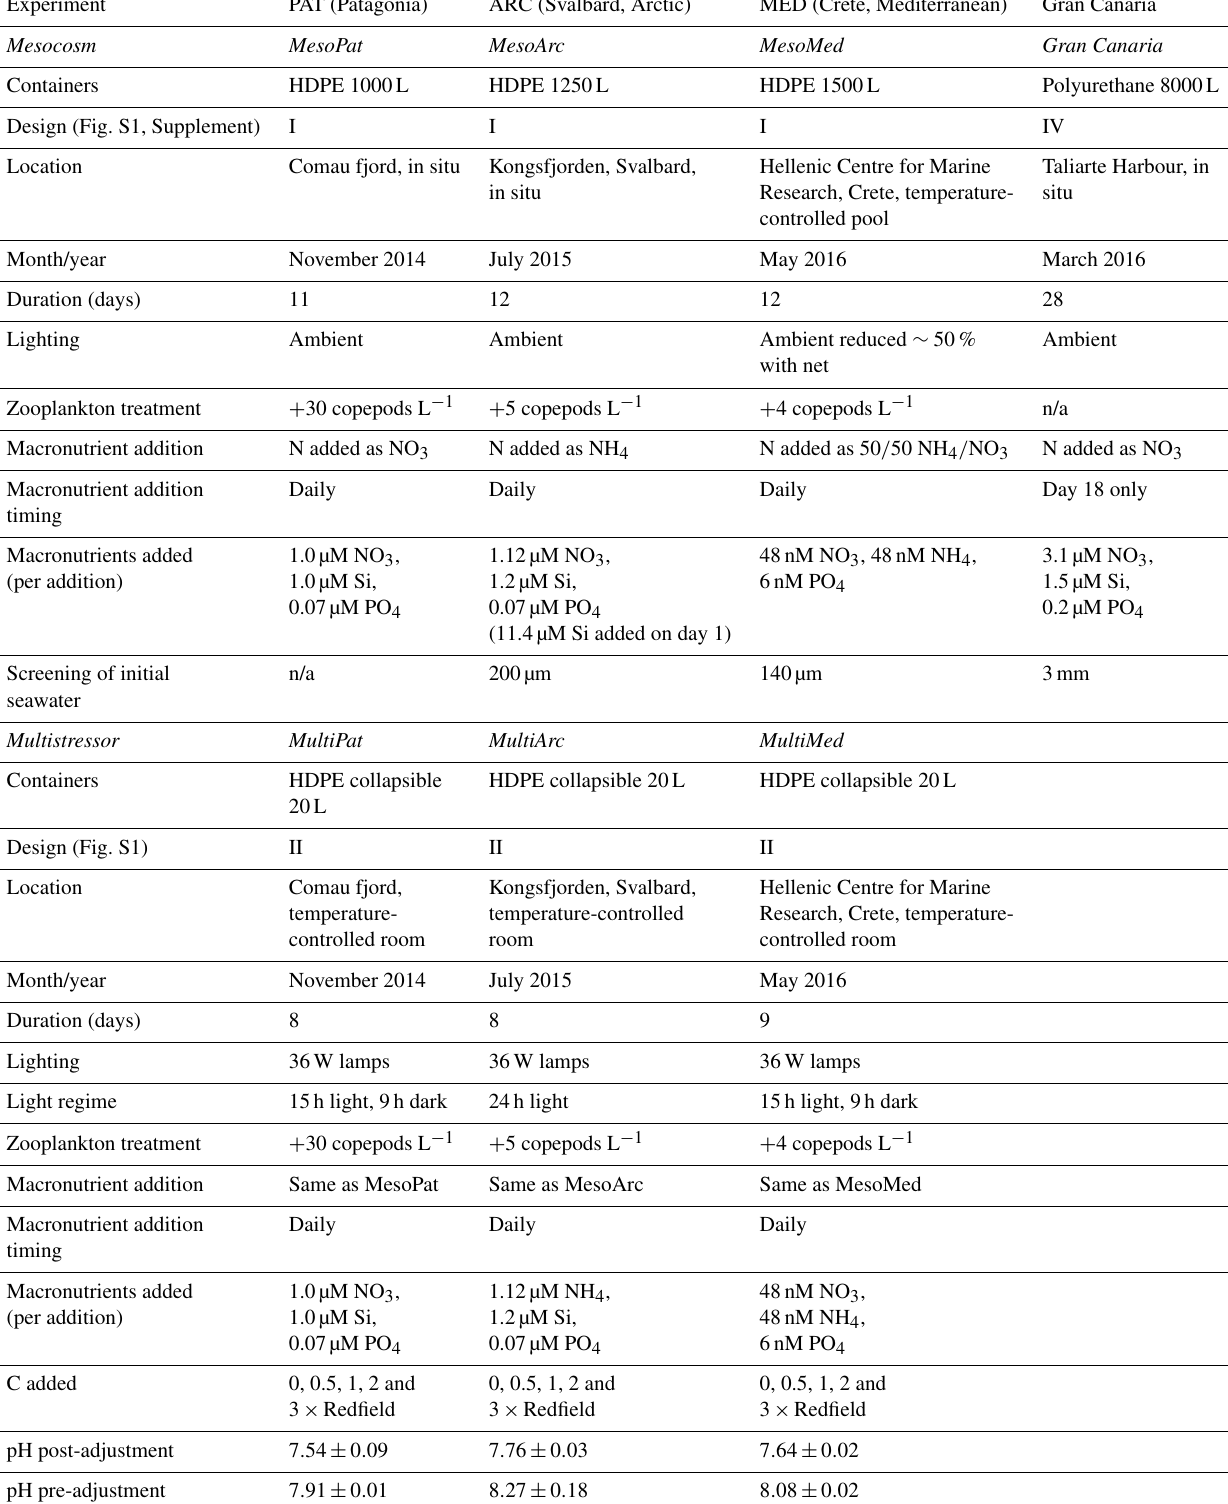
Table 1. Experiment details for each experiment. For a visual representation of experiment designs, the reader is referred to the Supplement. “HDPE” denotes high-density polyethylene. “n/a” denotes “not